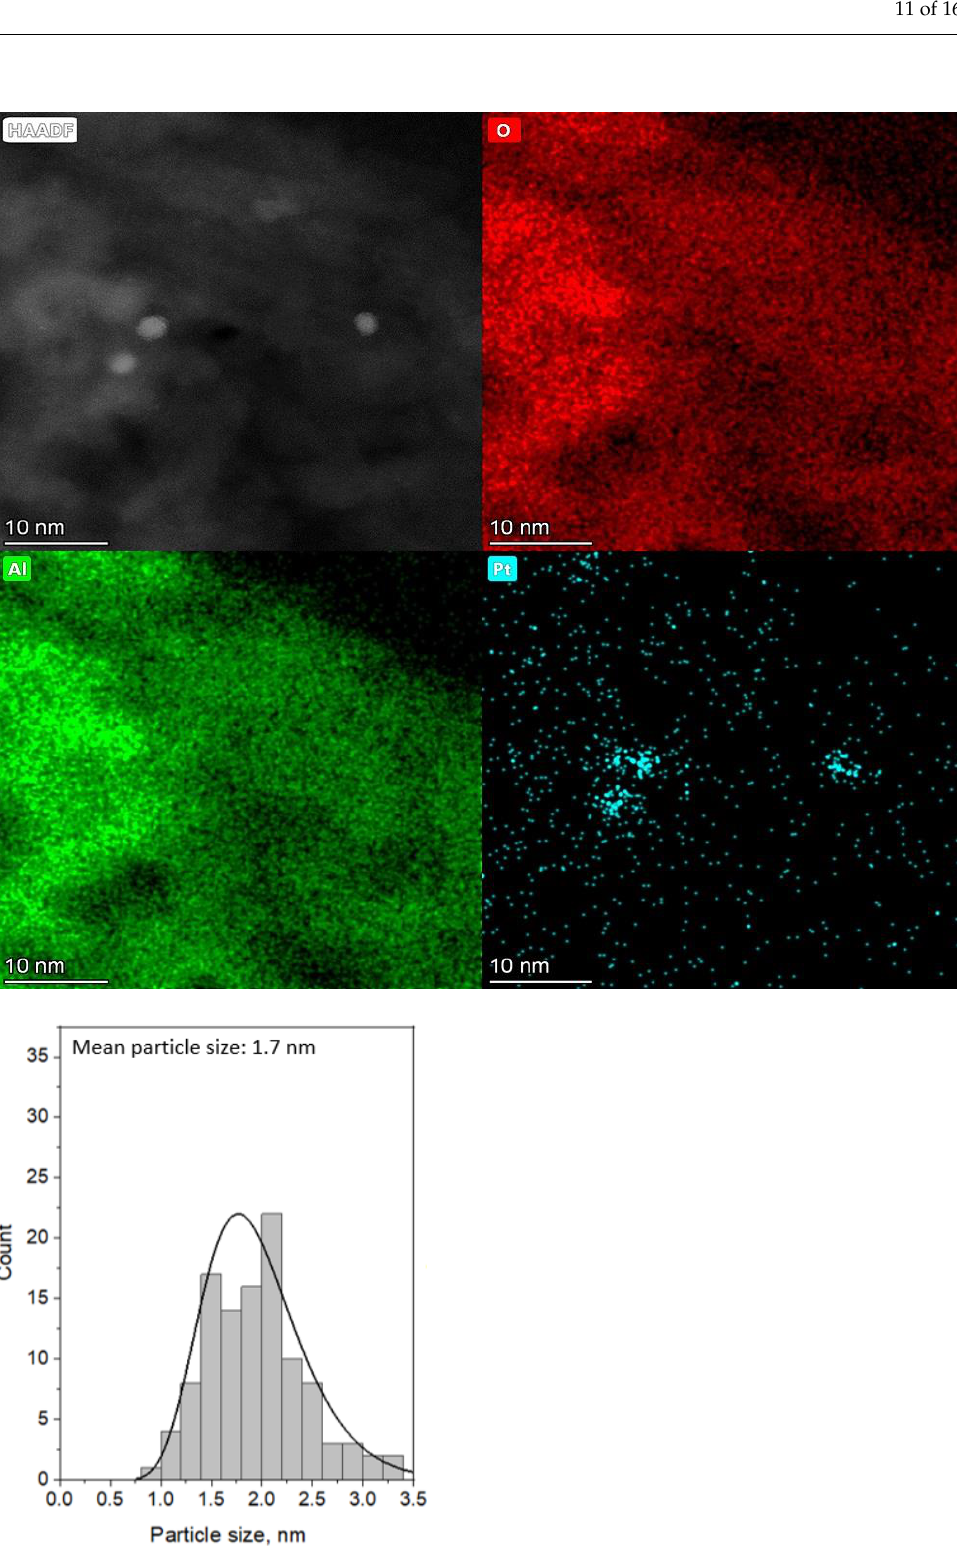
Figure 7. HAADF–STEM imaging, elemental EDS mapping images and particle size distribution from CAT-B catalyst prepared using WI. from CAT-B catalyst prepared using